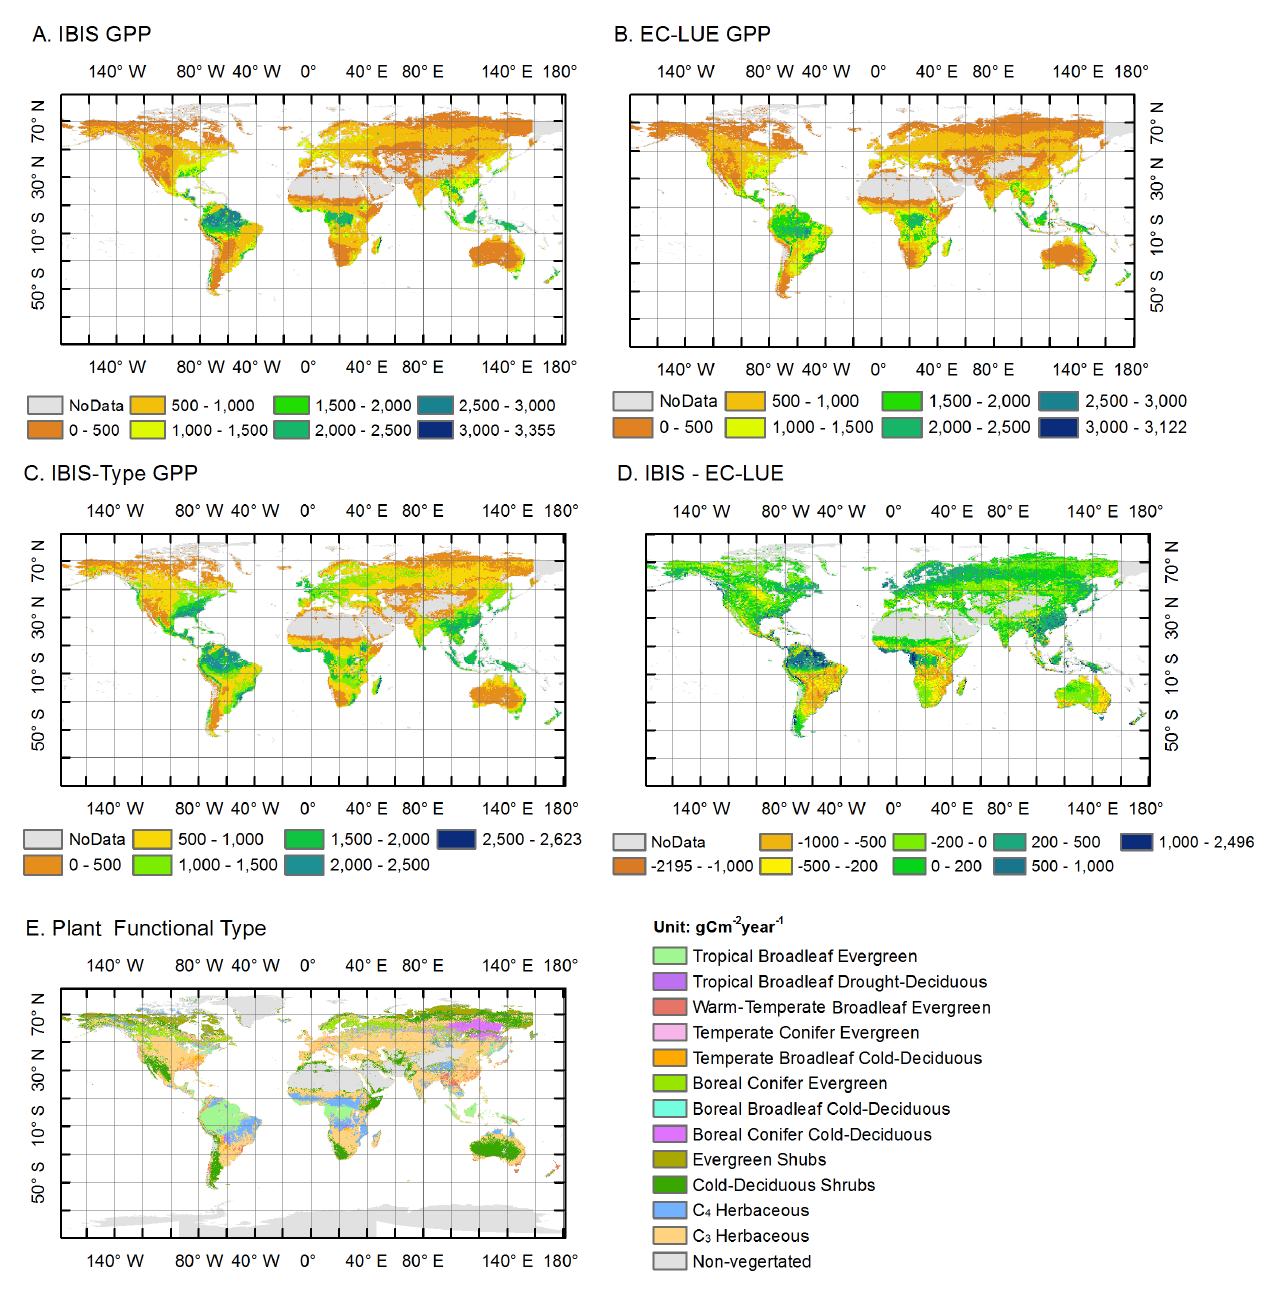
Figure 4. The global pattern of GPP. The global pattern of annual vegetation gross primary production (GPP) from 2000 to 2006. (a) estimated GPP using the IBIS model, (b) estimated GPP using the EC-LUE model, (c) estimated GPP using the IBIS-Type model, (d) the difference between the IBIS and EC-LUE models and (e) the spatial distribution of plant functional types (PFTs).